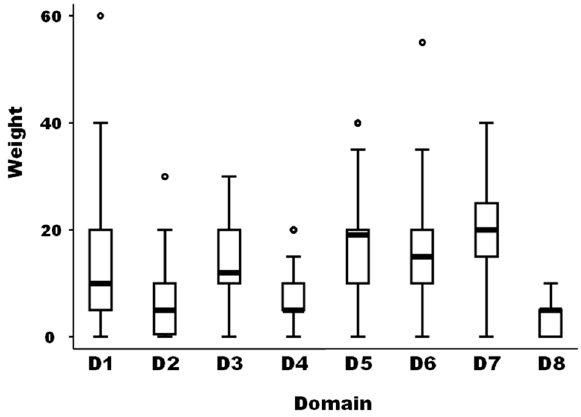
Figure 1. Boxplot of the relative importance of the eight domains of possible drivers of the observed emergence or increasing incidence of TBE in humans (N = 40 European experts). Legend: The bold line represents the median of the score distribution between the different experts attributed to each domain; the solid lines at the top and bottom of each rectangle represent, respectively, the first and third quartiles; adjacent lines to the whiskers represent the limits of the 95% confidence interval; small circles represent outside values. The eight domains of drivers are: D1, disease/pathogen characteristics; D2, distance to Europe and the country of the expert (spatial-temporal scales); D3, ability to monitor, treat, and control the disease; D4, European farm characteristics; D5, global change; D6, wildlife interface; D7, human activity; and D8, economic and trade